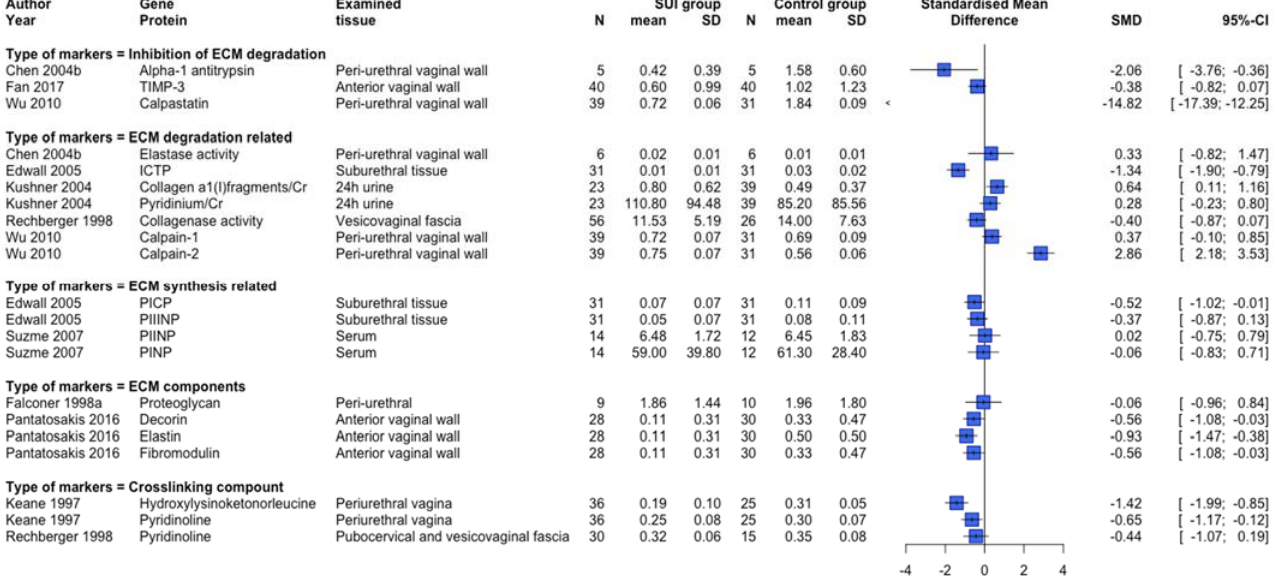
Figure 5. Forest plot of other extracellular matrix related protein expression and biomarker levels in human studies. This forest plot shows other extracellular matrix-related protein expression and biomarker level differences between patients with SUI and controls, subdivided per extracellular matrix metabolism-related theme. Abbreviations: CI confidence interval, N number, SD standard deviation, SMD standardized mean difference, SUI stress urinary incontinence.